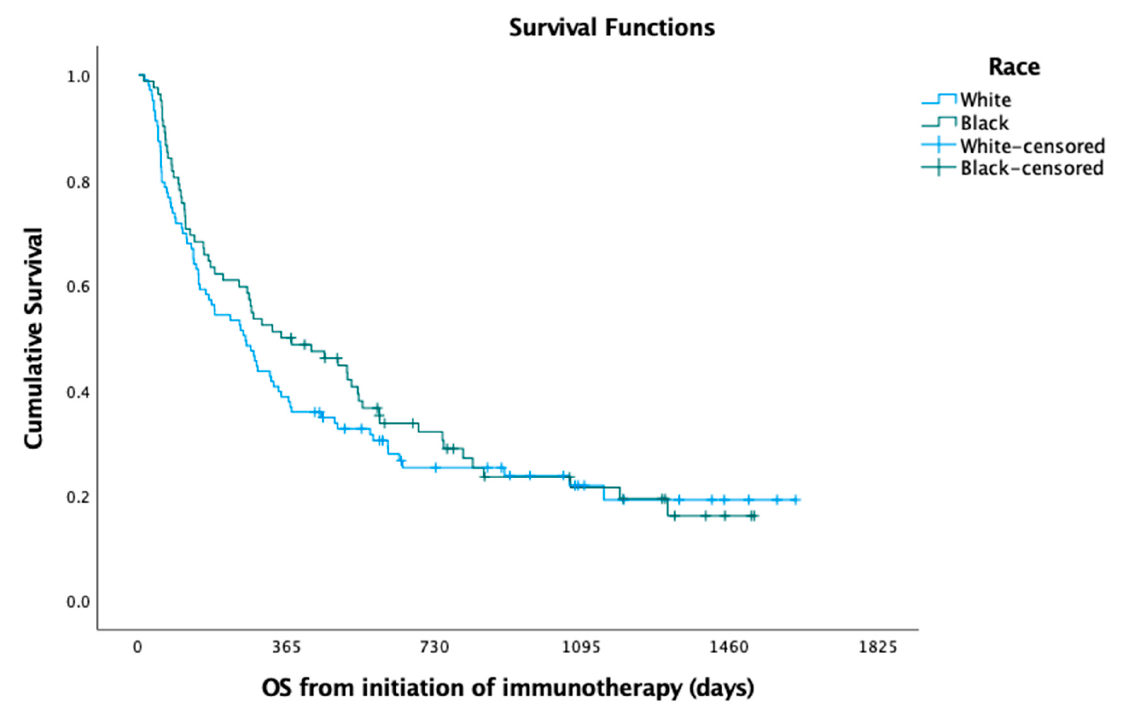
Figure 2. Overall survival (OS) among black versus white patients. Table 3. Multivariate Association between PFS and Demographic Characteristics of Stage IV NSCLC Patients.